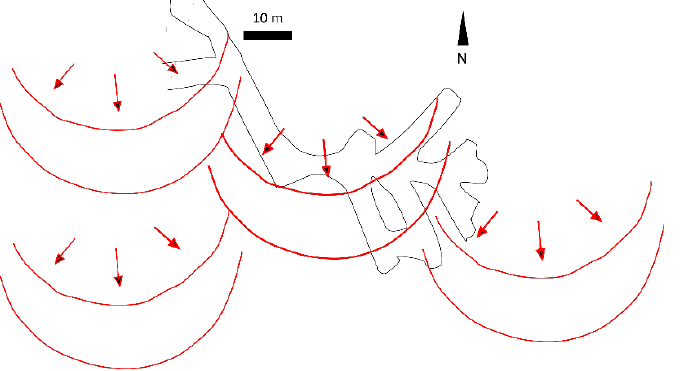
Figure 9. Schematic representation of typical conical orientation of gypsum branches in branching selenite lithofacies following [11,26] (in red) overlaid on the planimetry of the tunnels discussed in Figure 2 (in black).